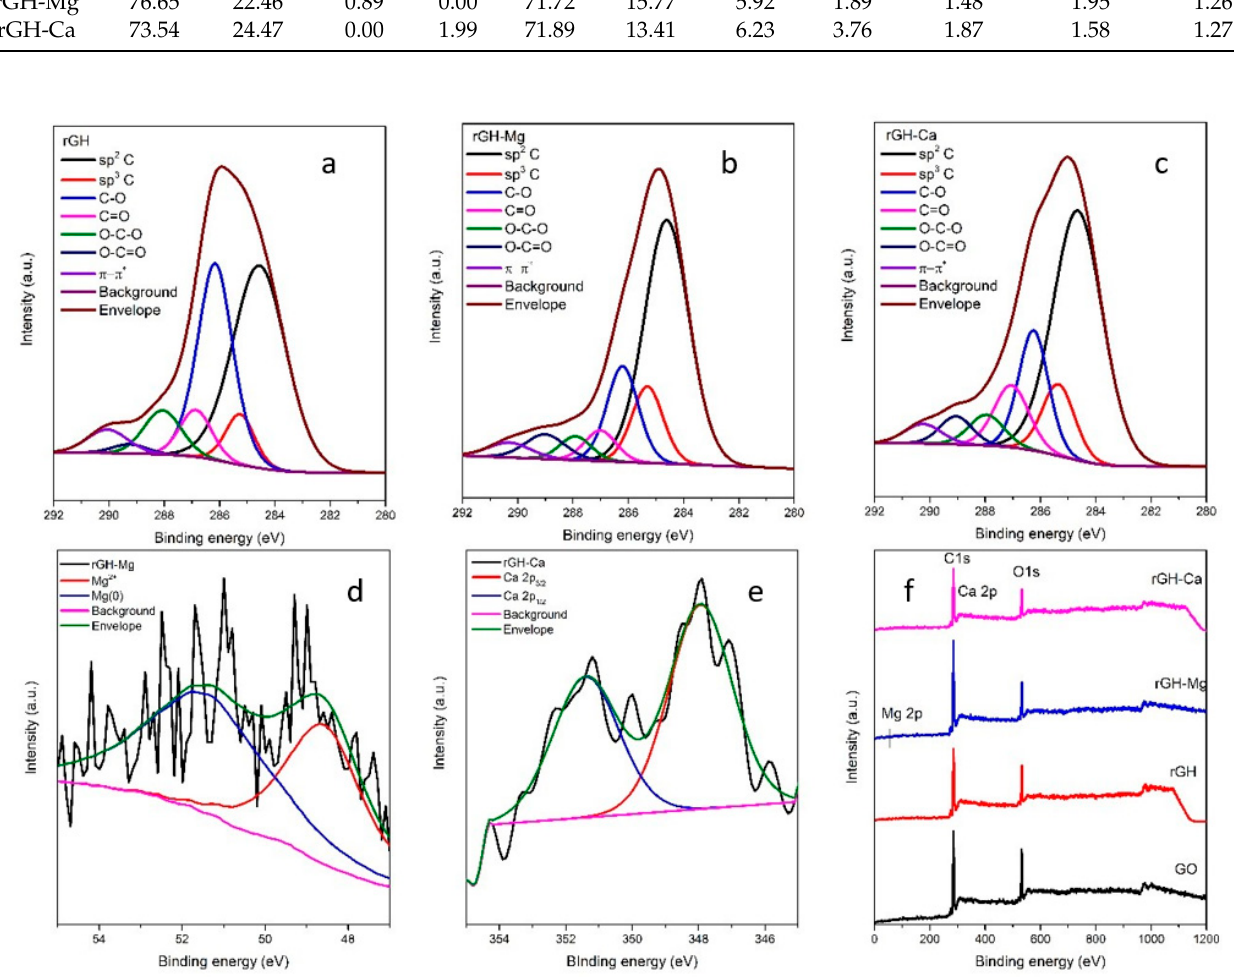
Figure 3. ( a – c ) C 1s split spectra of rGH, rGH-Mg, and rGH-Ca. ( d ) Mg 2p split spectra of rGH-Mg. ( e ) Ca 2p split spectra of rGH-Ca. ( f ) wide spectra of GO, rGH, rGH-Mg and rGH-Ca.